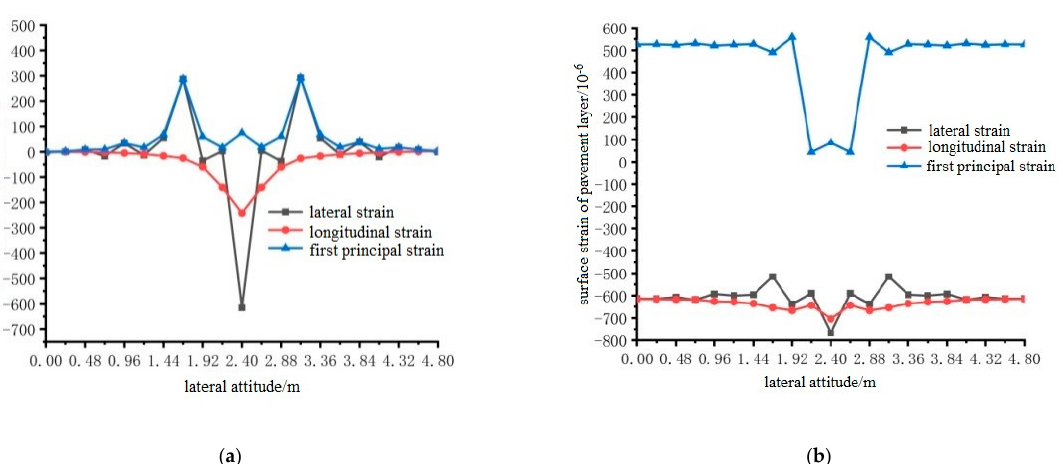
Figure 27. The transverse distribution of longitudinal and transverse strain on the surface of the pavement with and without temperature field under the action of load level 1. ( a ) Longitudinal and transverse strain diagrams without temperature field effect; ( b ) Longitudinal and transverse strain diagrams with temperature field effect.